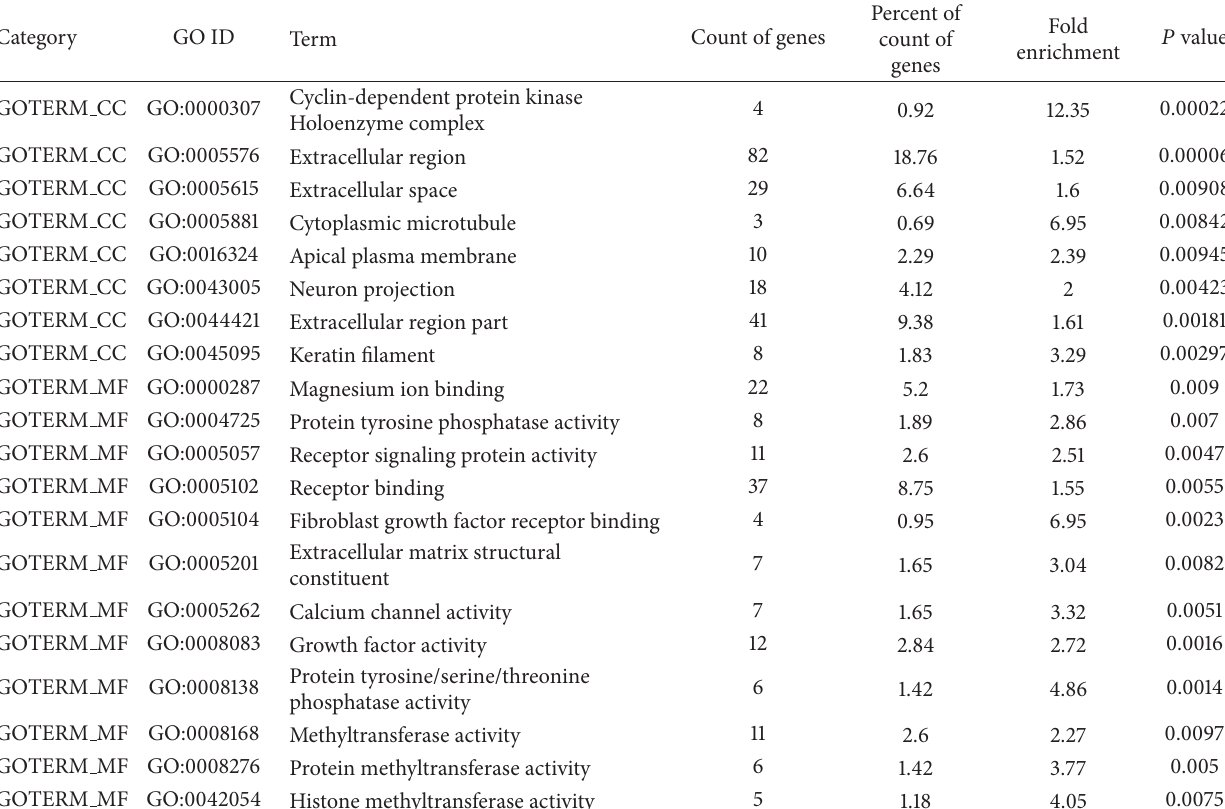
Table 3: GO analysis of differentially expressed genes associated with the cellular location and molecular function.